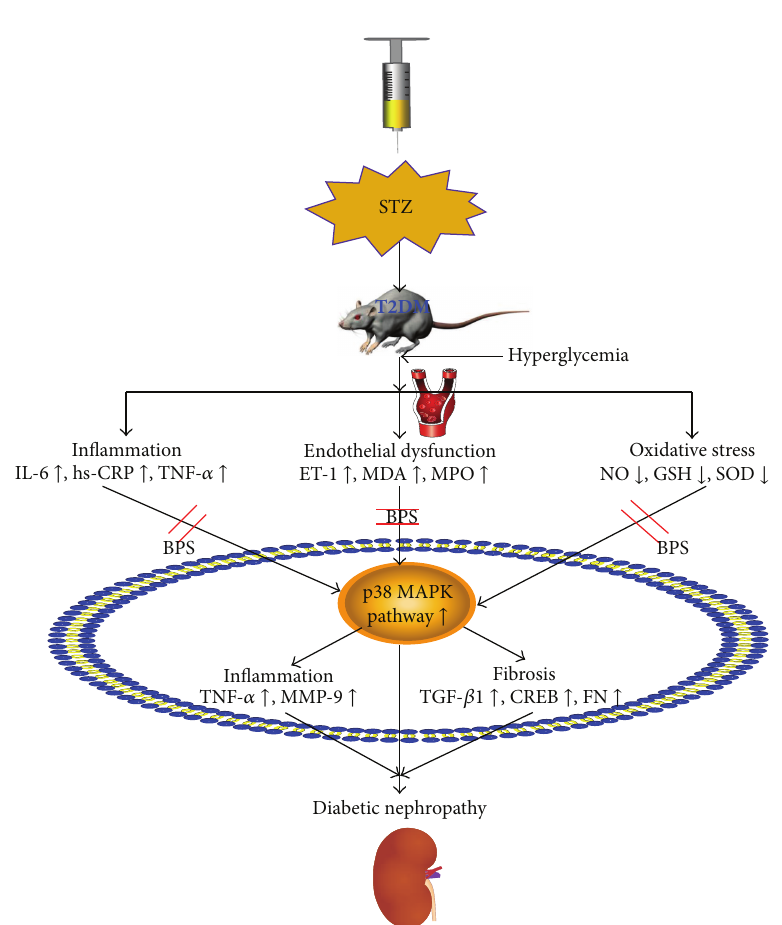
Figure 8: Protection mechanisms of BPS in diabetic